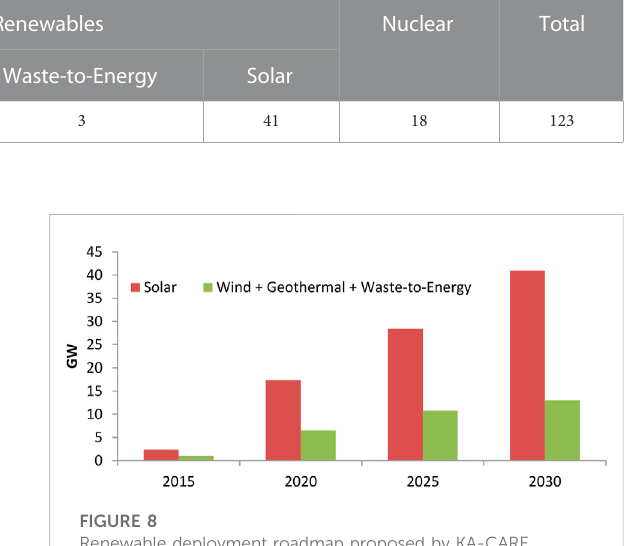
FIGURE 8 Renewable deployment roadmap proposed by